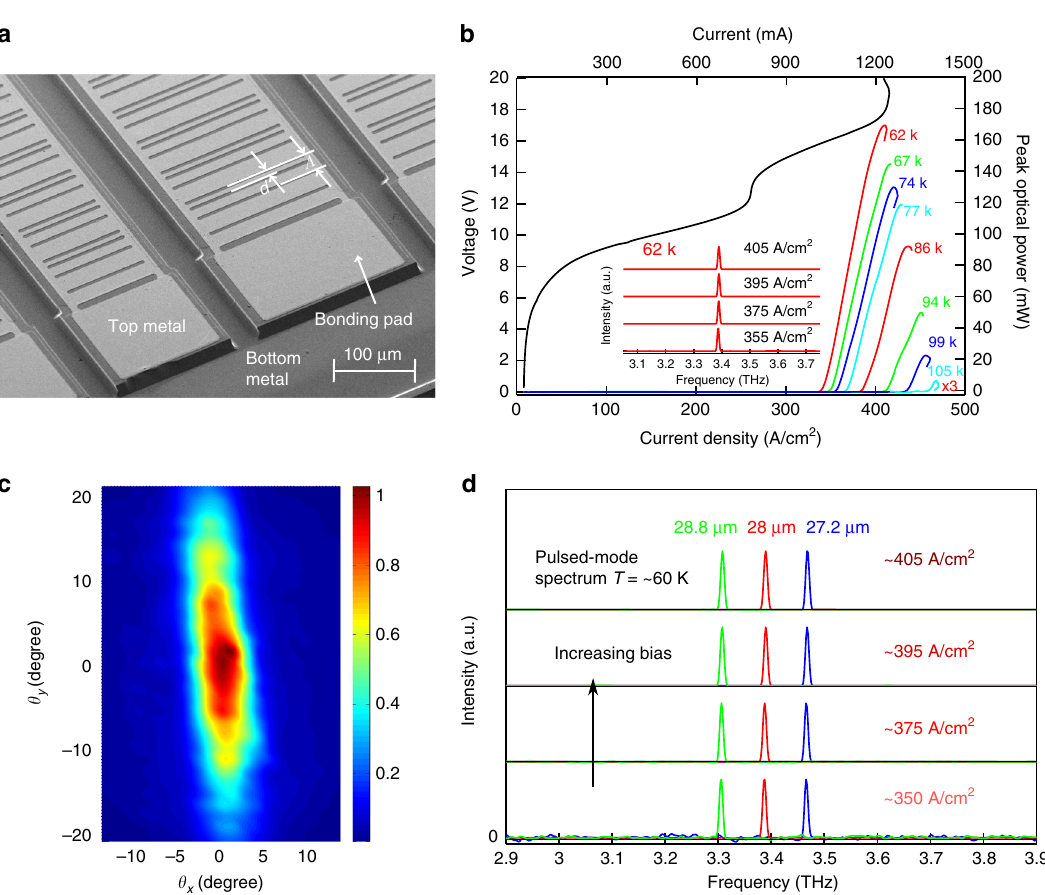
Fig. 4 Experimental results. a Scanning electron microscope image of the fabricated terahertz QCLs with hybrid DFB gratings as in Fig. 2a. b Current – voltage ( I – V ), and spectral intensity (inset) at different electric bias at a heat-sink temperature of 62 K, and light – current characteristics at different temperatures measured in pulsed mode of operation. The terahertz QCL is of dimensions 10 μ m×200 μ m×1.5 mm, grating period Λ = 28 μ m, and d / Λ = 3/8. c Far- fi eld radiation pattern (optical intensity) measured at 62 K close to the peak-bias (~405A cm − 2 ) at a distance of 40 mm from the QCL in the surface-normal direction. θ x and θ y are angles with respect to the surface normal along the longitudinal and lateral dimensions of the QCL cavity, respectively. d Spectral characteristics of three different QCLs located neighboring each other on the wafer with different grating periods, and d / Λ = 3/8 for each